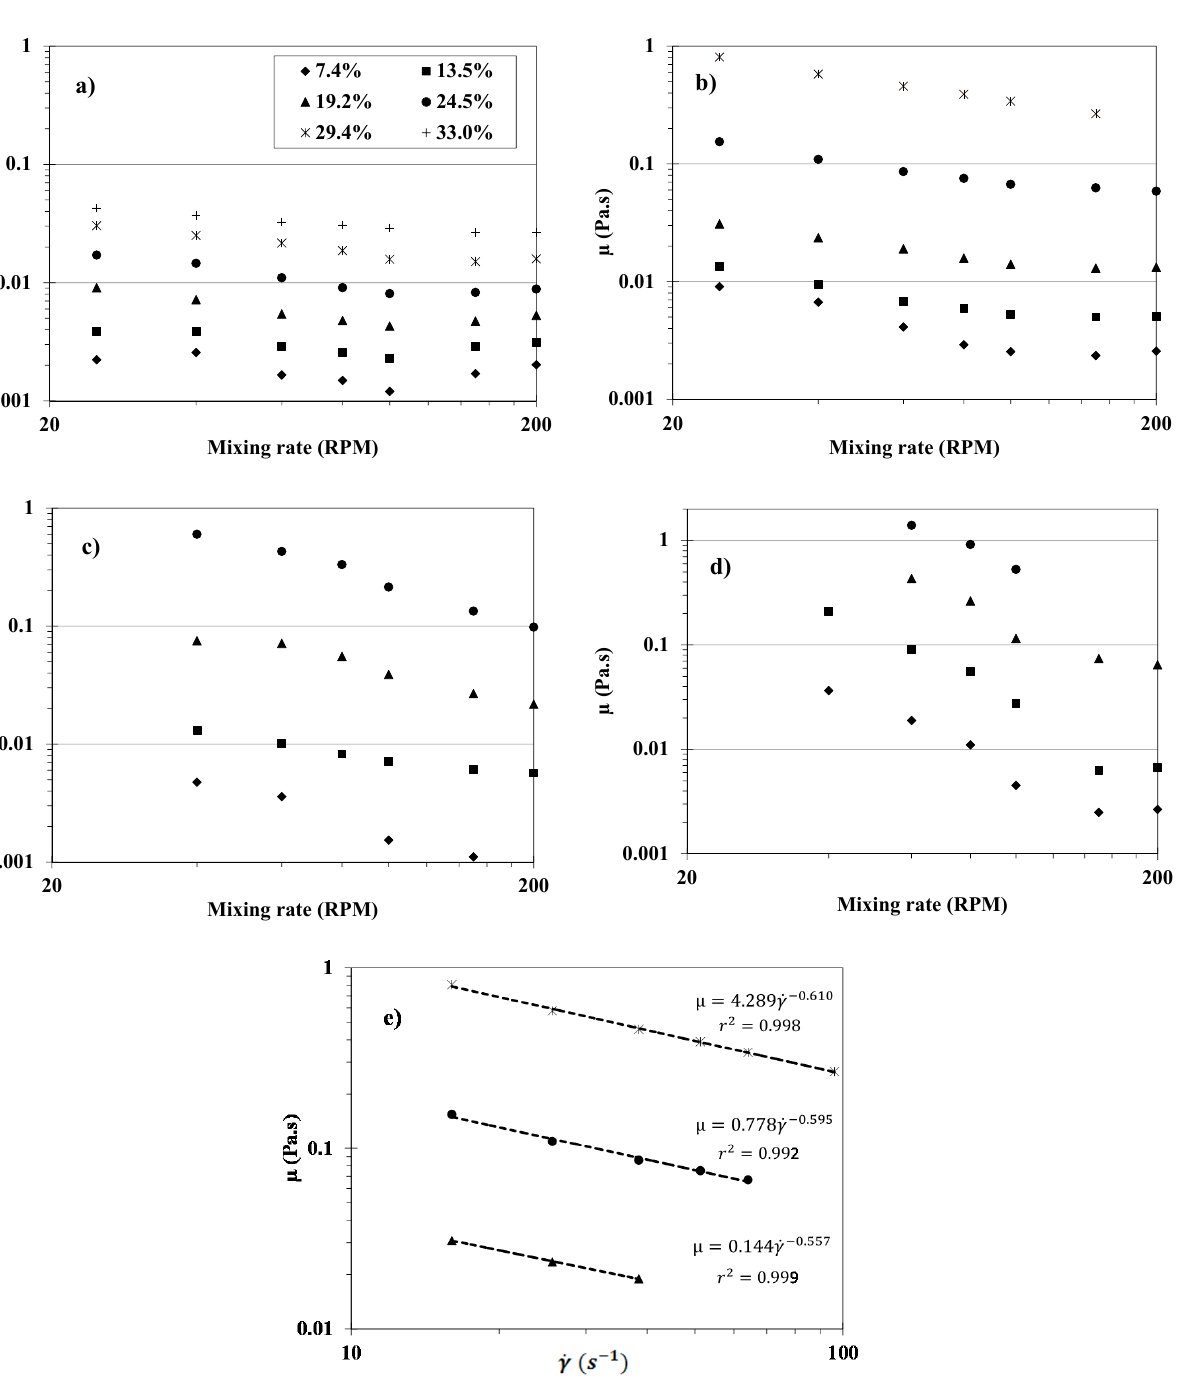
Figure 3. Suspension viscosity versus mixing rate and concentrations at 50 °C: ( a ) CR075, ( b ) CR125, ( c ) CR250, ( d ) CR500 and ( e ) viscosity as a function of shear rate—example for CR125 (only for the laminar regime) (CR075, CR125, CR250, and CR500 are cassava flour with the particle sizes of under 75 µm, 75–125 µm, 125–250 µm, and 250–500 µm, re- spectively).